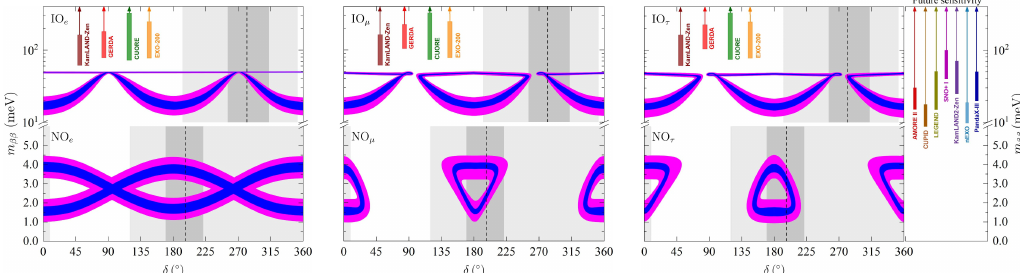
Figure 2 . Effective neutrino mass parameter m ββ as function of the Dirac CP-violating phase for the 5 e (left), 5 µ (center) and 5 τ (right) cases (the colour codes are the same as in figure 1). In each 1 1 1 panel we show the NO and IO results in the lower and upper fraction of the vertical scale, respec- tively. We also show the upper bounds on m reported by the KamLAND-Zen [78], GERDA [79], ββ CUORE [80] and EXO-200 [81] collaborations (the height of the corresponding rectangles represent the uncertainty in the upper bounds). On the right the sensitivity of several future experiments is